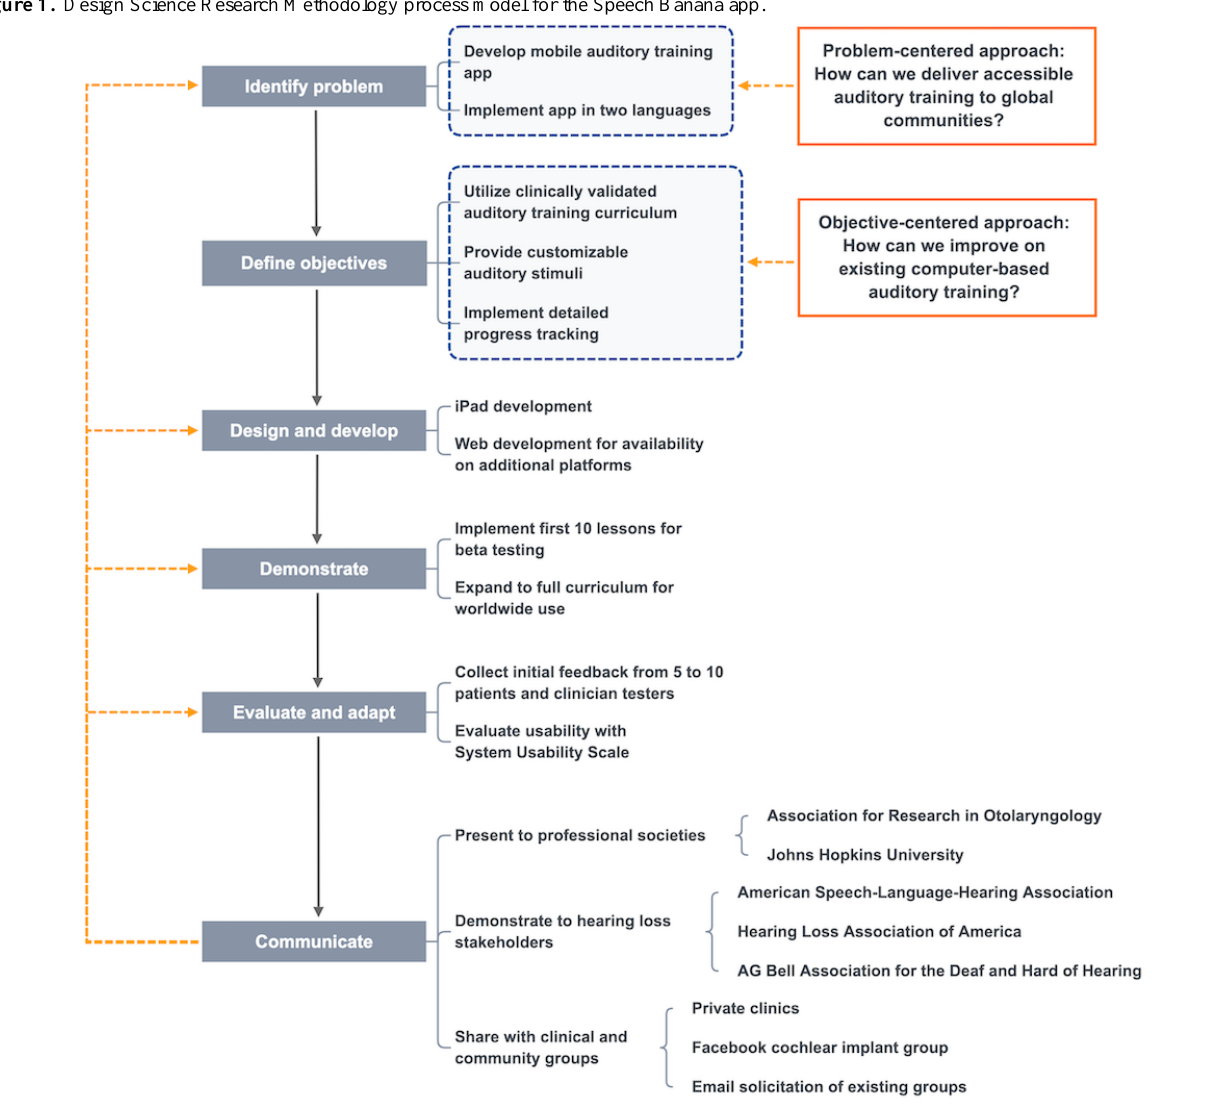
Figure 1. Design Science Research Methodology process model for the Speech Banana